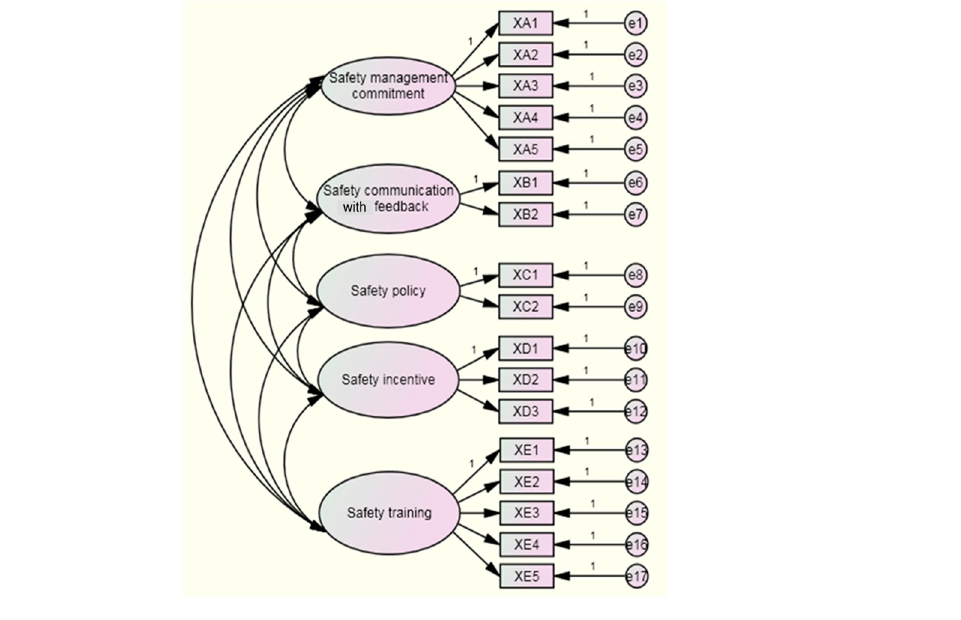
Figure 2. The five-factor structural